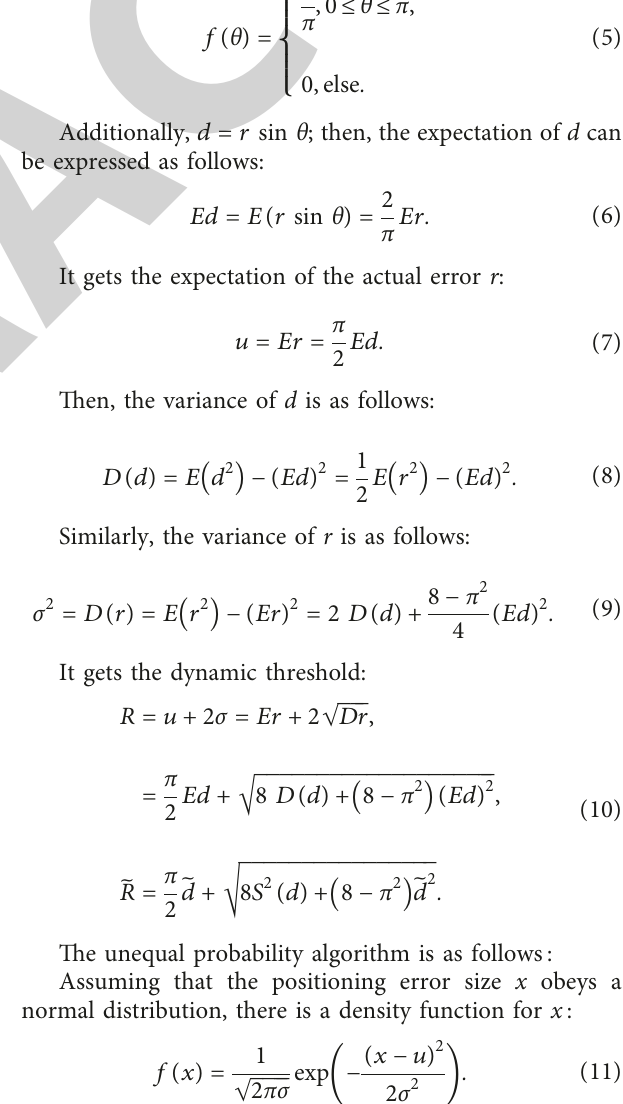
Figure 4: Equal probability dynamic threshold